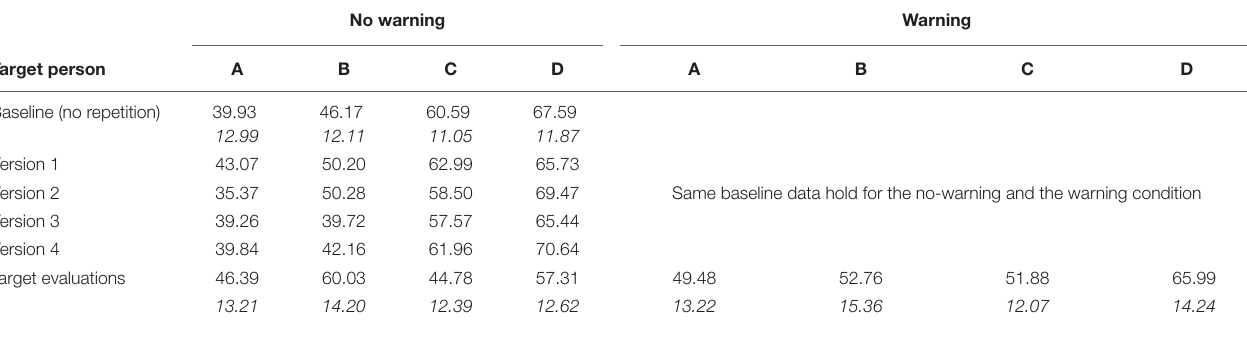
TABLE 4 | Means and standard deviations (italics) of target evaluations obtained in Experiments 3 as a function of instruction conditions (warning vs. no